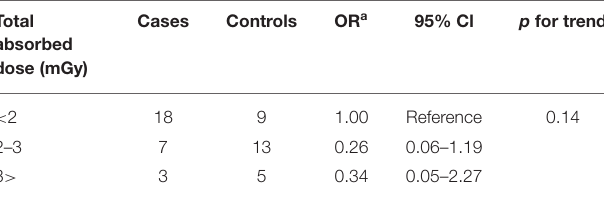
TABLE 4-2 | Distribution of subjects and OR s for lung cancer according to estimated radon, thoron absorbed dose (Using dose conversion factor derived from